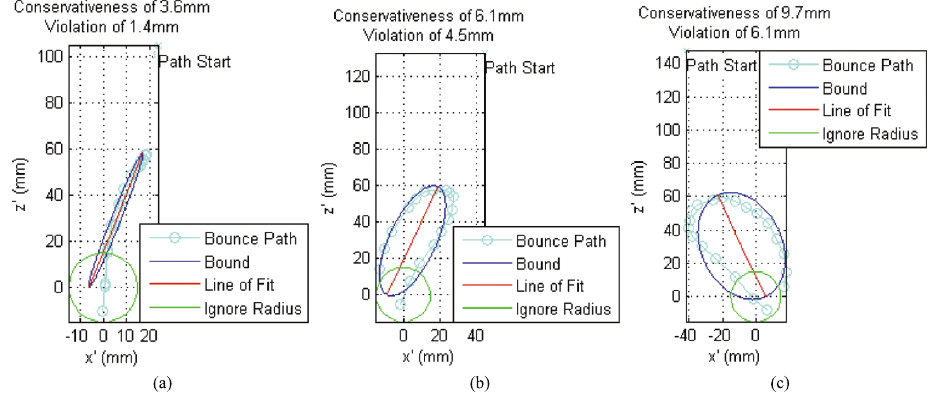
Fig. 18. The parameterized perform well for central starting points.